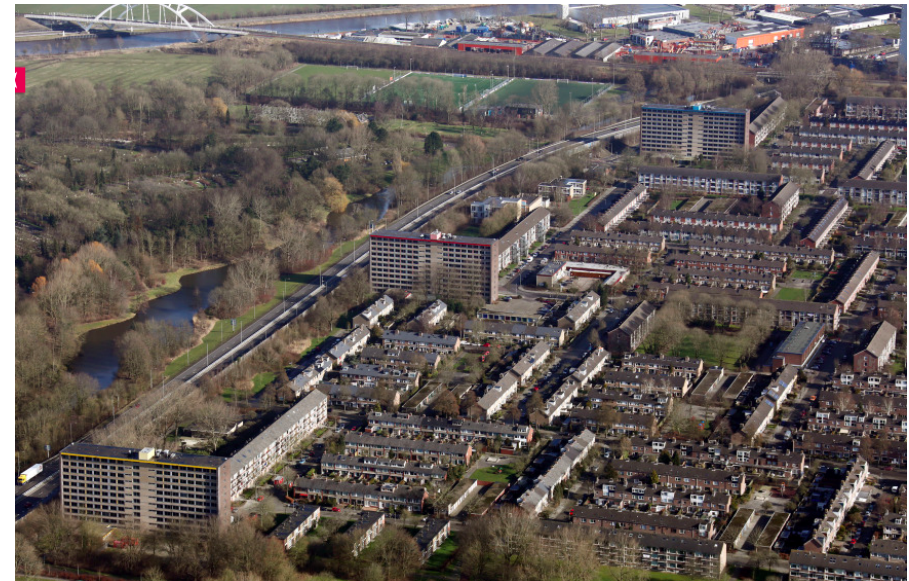
Figure 3. Selwerd seen from above, with three student flats located on the left. Retrieved from staatingroningen.nl In 2013, a neighbourhood renewal programme com- menced in Selwerd and the student lock was abolished in 2015.